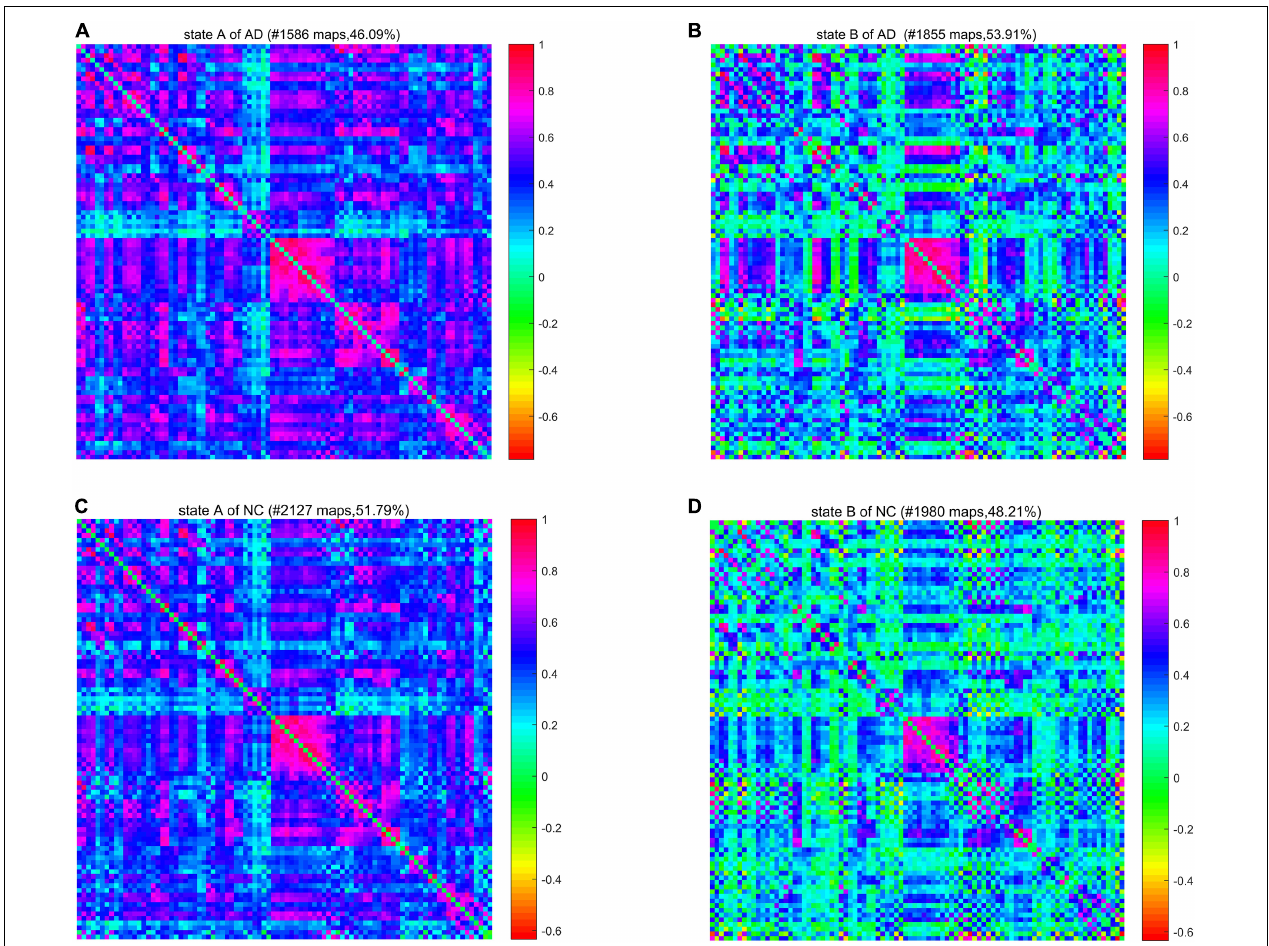
FIGURE 5 | The cluster center diagram of spatiotemporal automated anatomical labeling (AAL) networks for Alzheimer’s disease (AD) and normal control (NC).